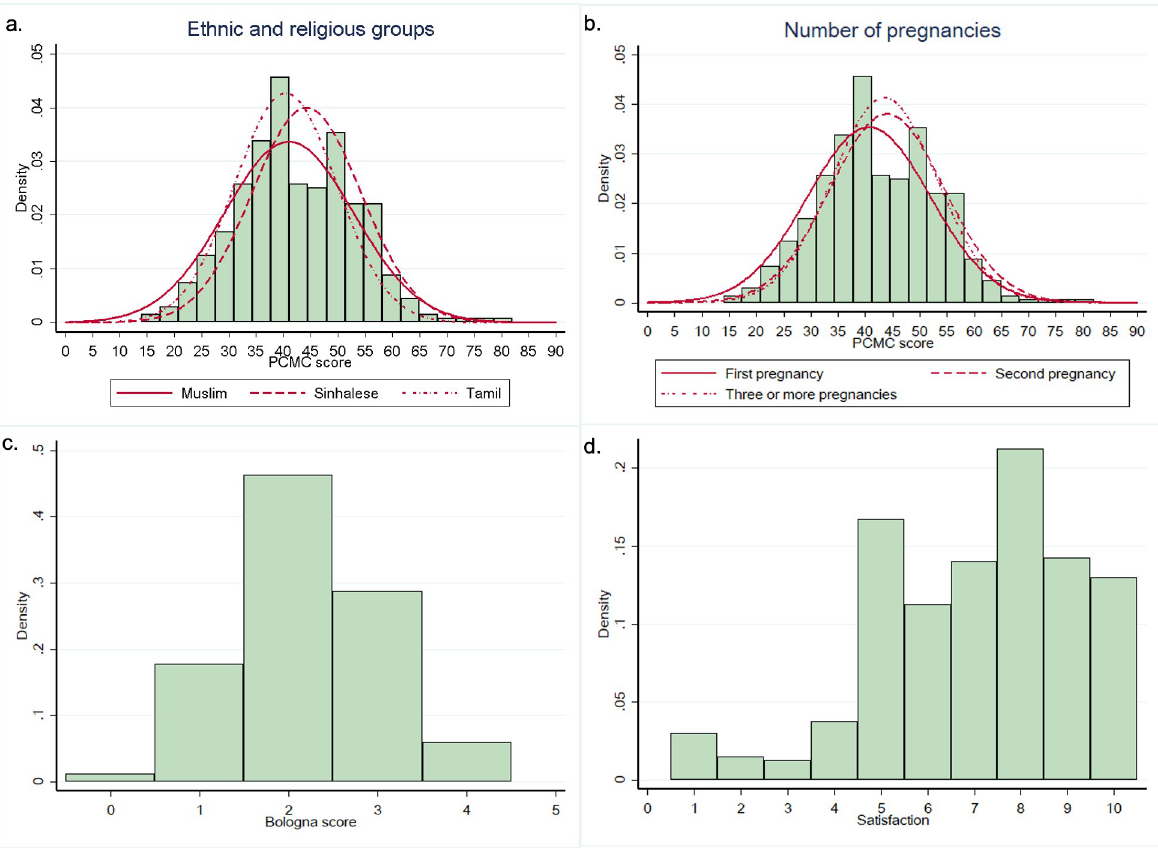
Fig 1. Distribution of PCMC, Bologna score and women’s satisfaction Likert scale. Panel a) PCMC score distribution by ethnic and religious groups. Panel b) PCMC score distribution by number of pregnancies. Panel c) Bologna score distribution. Panel d) Women’s satisfaction Likert scale distribution. PCMC score distribution by groups was added for significant variables in multivariate analysis different from Bologna score components.